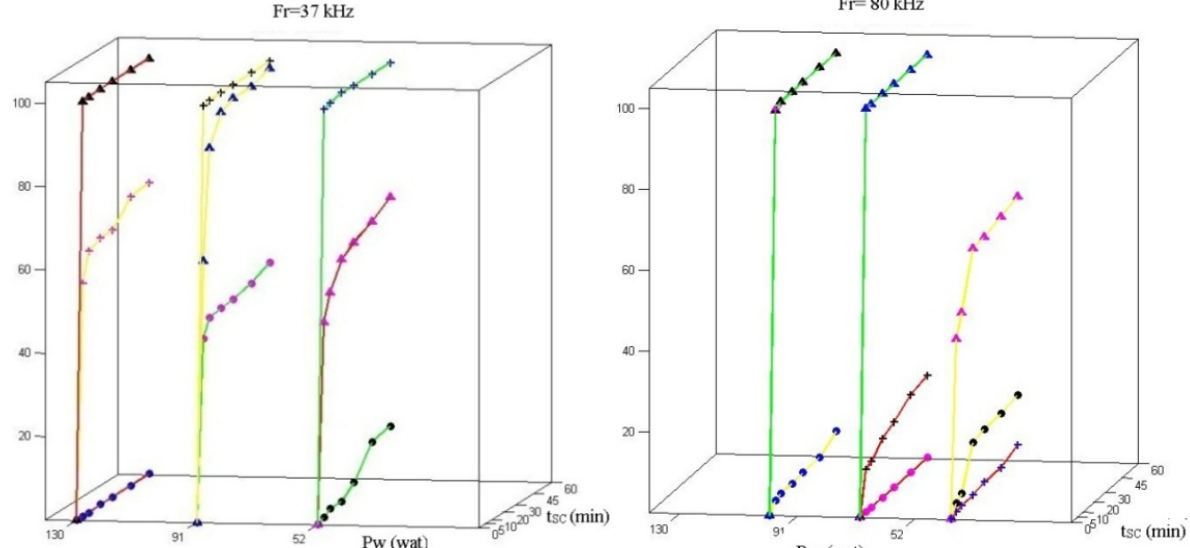
Figure 1. DR% of 18 complete runs (green line (C0=20 mg/Lit), yellow line (C0=120 mg/Lit), red line (C0=220 mg/Lit)/ circle marker (DSC=0.1 g/Lit), plus sign marker (DSC=1 g/Lit), triangle marker (DSC=1.9 g/Lit)/ black marker (pH=3), magenta marker (pH=7), and blue marker (pH=10)).